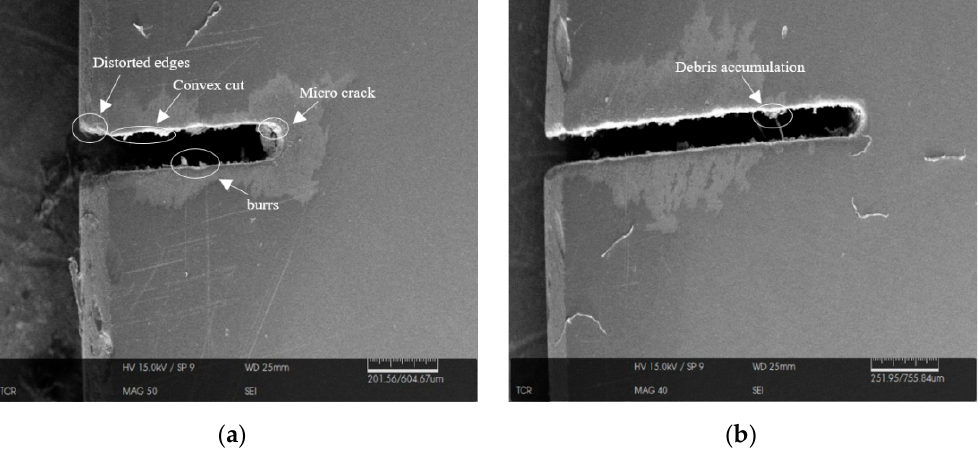
Figure 10. SEM images of slits produced ( a ) without using the MHD approach and ( b ) using the MHD approach.